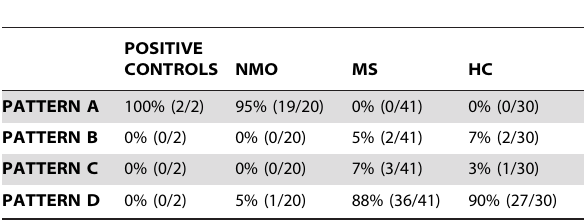
Table 2. Association between fluorescence patterns and clinical status of all the analyzed samples (2 commercial anti- AQP4 positive controls, 20 NMO samples, 41 MS samples, 30 healthy